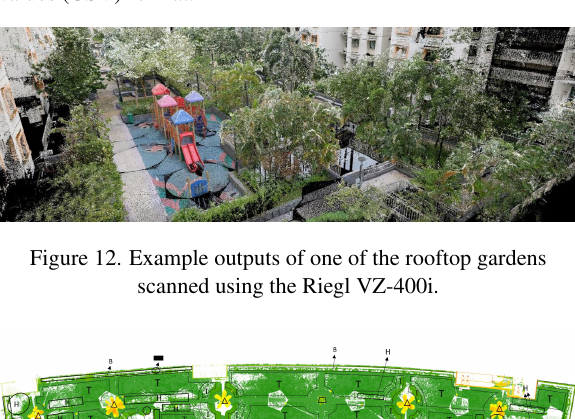
Figure 11. A sample of shrub output IFC model. palms and 32 species of shrubs in a simple comma-separated values (CSV) format.